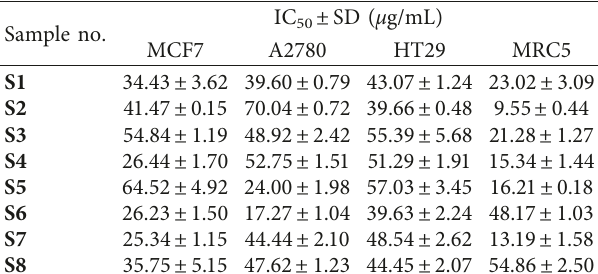
Table 2: Cytotoxic activity of the eight extracts against three cell lines and one normal fibroblast (MTT 72h IC 50 ± SD μ g/mL). Sample